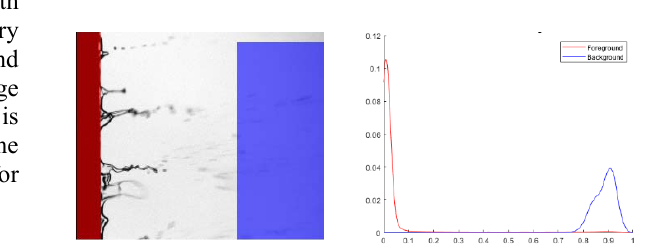
Fig. 8. Equalized image. Fig. 9. Enhanced histogram.